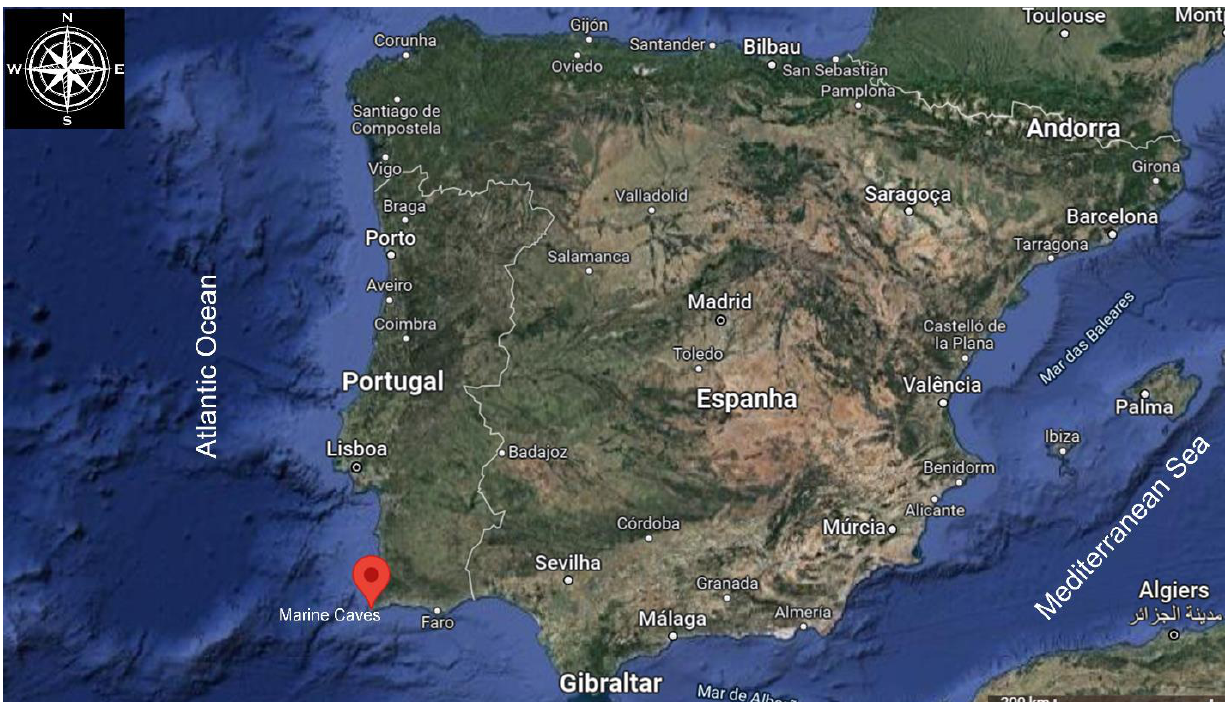
Figure 1. Geographical location of Catedral and Queijo Suiço marine cave in Sagres (southern Portugal), from which the marine organisms were collected. Maps retrieved from Google Maps.